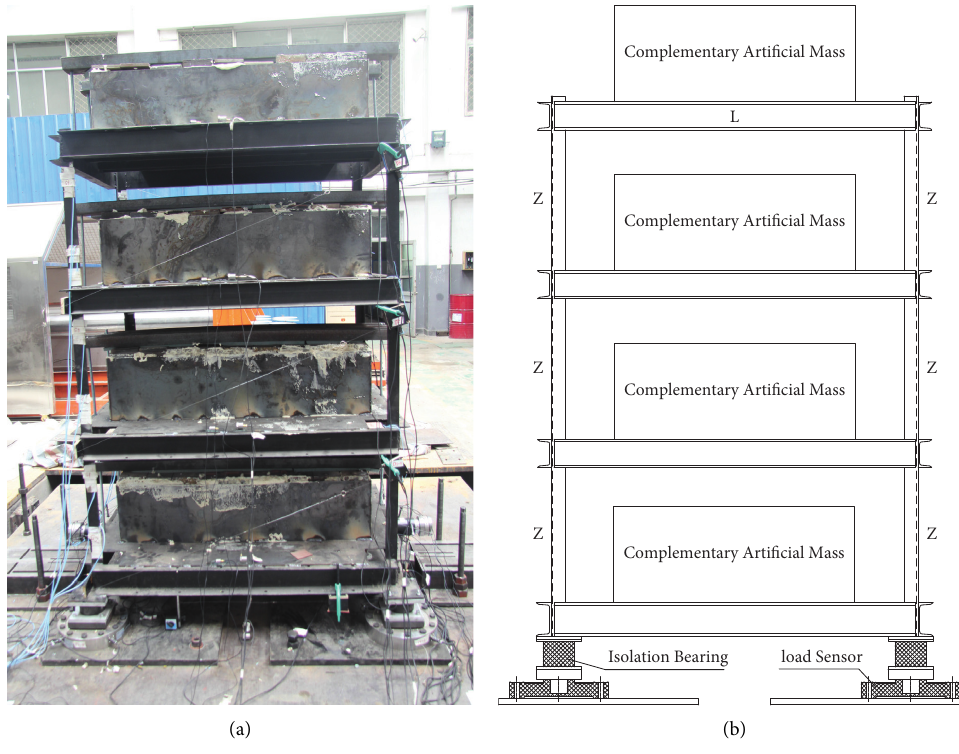
Figure 1: Experimental model: (a) picture and (b) sketch.